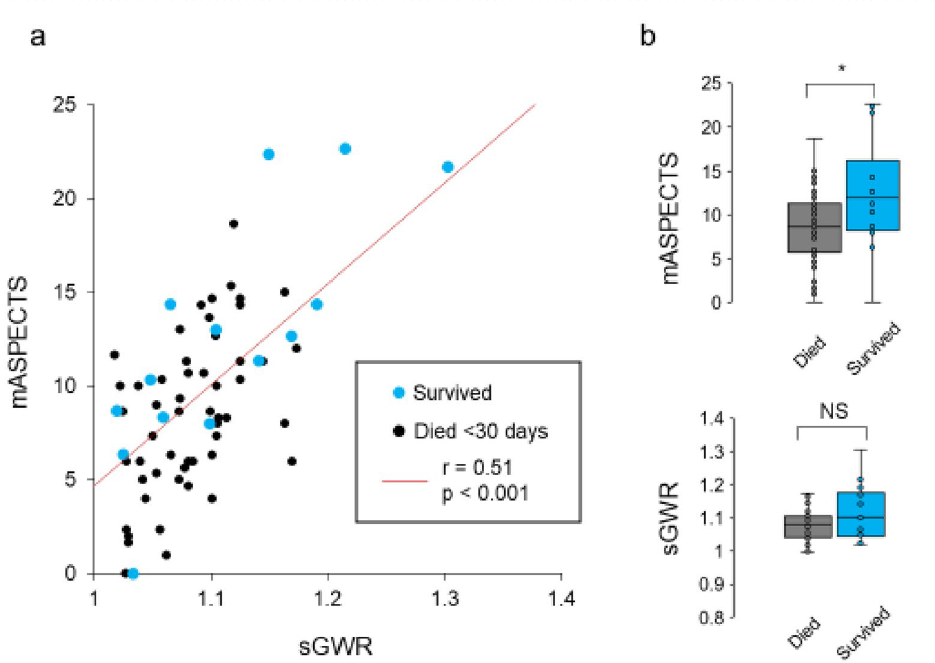
Figure 3. Correlation of the mASPECTS and sGWR scores. ( a ) The scatter plot shows the sGWR (X) and mASPECTS (Y) of survivors (blue dots) and non-survivors (black). Spearman’s correlation coefficients are shown in the plots. ( b ) The box plots represent the mASPECTS (upper) and sGWR (lower) scores of survivors and non-survivors. NS, not